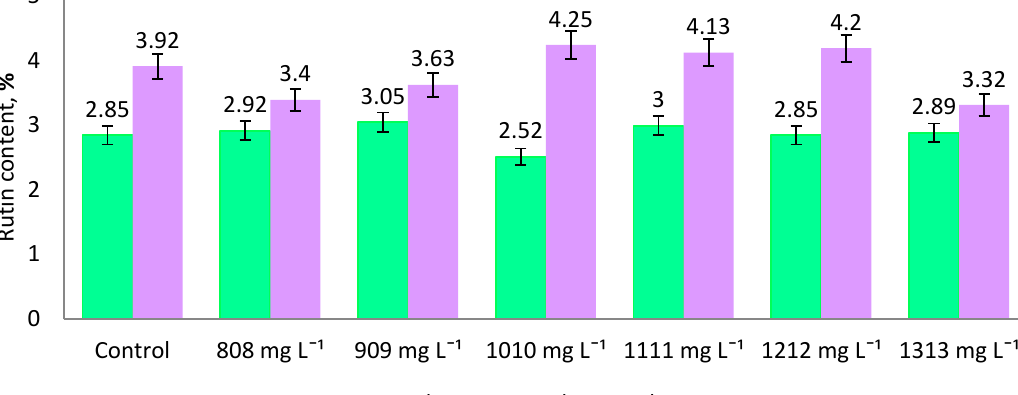
Figure 5. Rutin content in F. esculentum regenerants cultured in vitro during III-V passages on the MS after exposure to selective media with zinc.